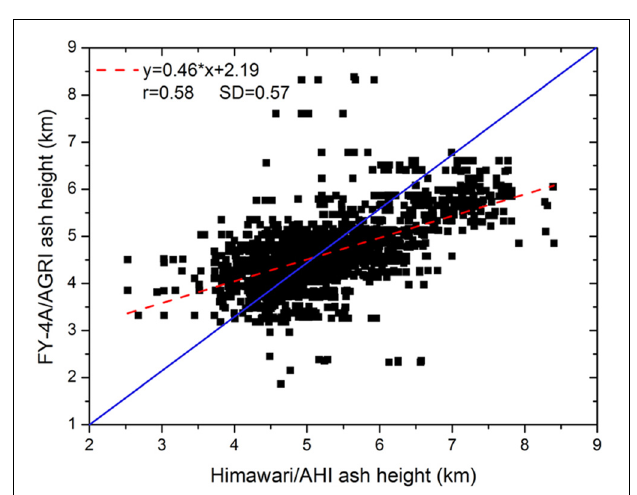
FIGURE 4 | Volcanic ash height derived from FY-4A/AGRI (00:00 UTC 27 November 2017) (4 km resolution for ash detection and ash height retrieval).